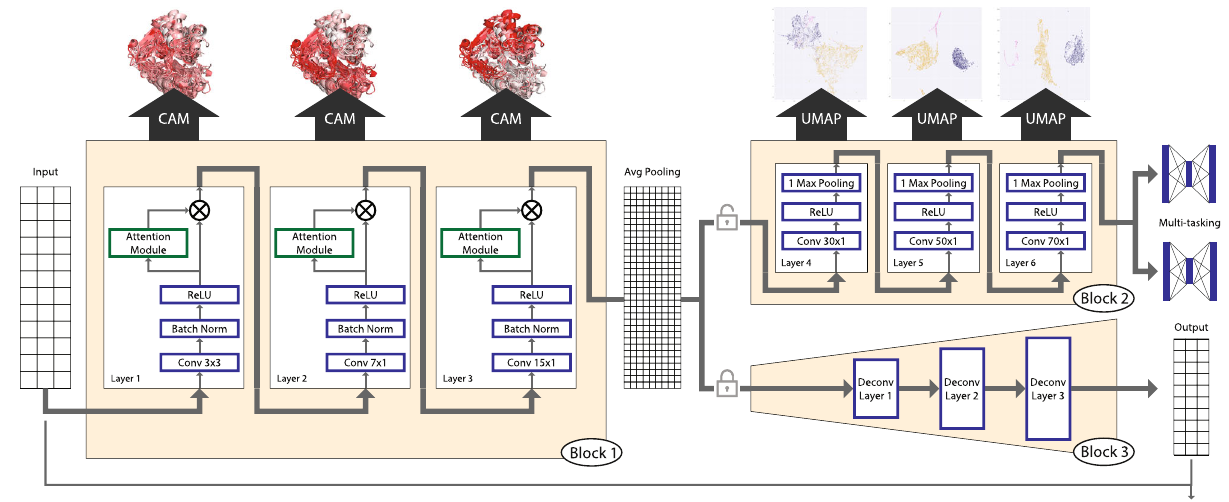
Fig. 1 Overall schematics of the deep-learning model used. A three-state secondary structure prediction matrix for each sequence is used as input to Block 1. Block 1 includes the fi rst three sequential one-dimensional convolutional layers with attention for feature maps re fi nement. Feature maps from Block 1 are passed through a global average pooling for dimension reduction and fed into Block 2 with three additional convolutional layers, and fi nally used to make predictions for both fold and family. Blocks 1 and 2 constitute the deep CNN model for classi fi cation. Using Grad-CAM, features from Block 1 are mapped back into sequences and structures for interpretation. Features from Block 2 are passed to UMAP for dimensionality reduction and visualization. Weights and features from Block 1 are frozen and used in an encoder that is passed to Block 3 which is the decoder with multiple deconvolution steps that complete an autoencoder model. Reconstruction error ( ε ) from this model is used to make predictions of fold type on GT families with unknown folds